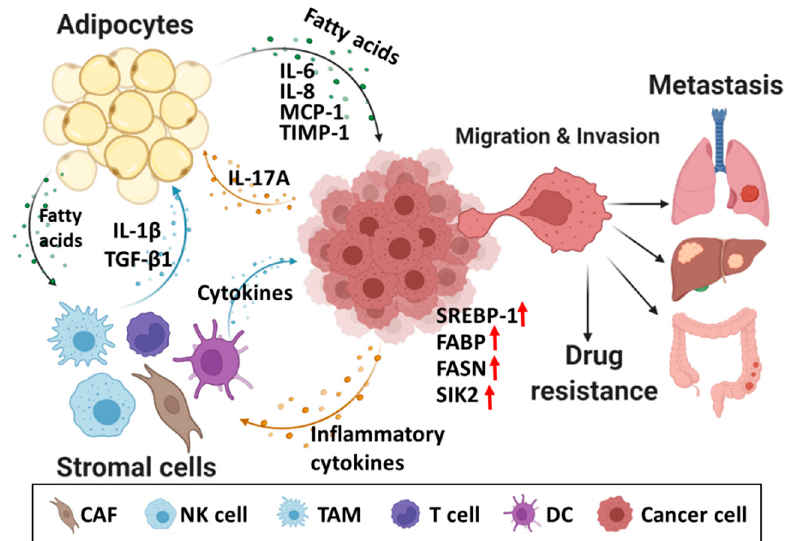
Figure 2. Fatty acid metabolism in the TME of ovarian cancer. Fatty acid-mediated lipid metabolism in TME is well controlled by cancer cells, adipocytes and stromal cells with complex processes, leading to ovarian cancer metastasis and drug resistance. CAF, cancer-associated fibroblast; NK cell, natural killer cell; TAM, tumor-associated fibroblast; DC, dendritic cell; SREBP-1, sterol regulatory element binding protein 1; FABP, fatty acid binding protein; FASN, fatty acid synthase; SIK2, salt-inducible kinase 2; MCP-1, monocyte chemoattractant protein-1; TIMP-1, tissue inhibitor of metalloproteinase-1; TGF- β 1, transforming growth factor β